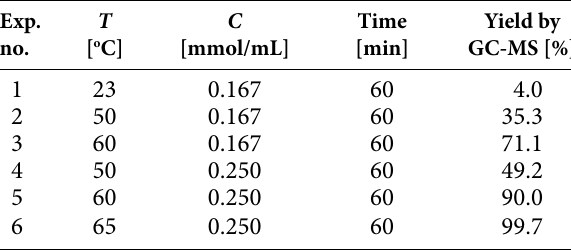
Table 2 . Experimental set-up employed in the optimization proce- dure. Exp.